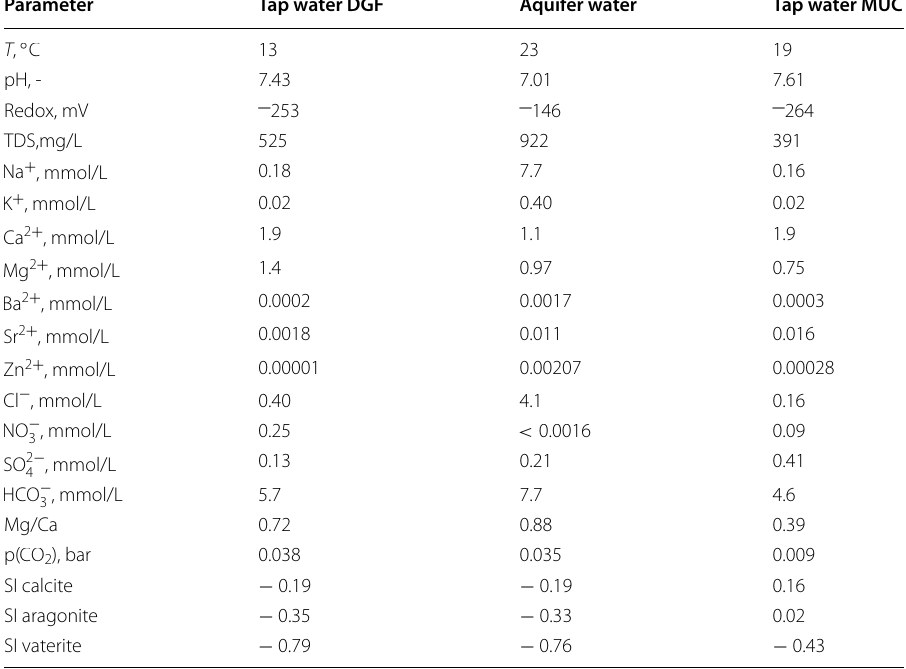
The calculated partial pressures of CO 2 and SI are listed below (tap water for T = 20 ◦ C and p total = 1bar ; aquifer water refers to reservoir conditions)